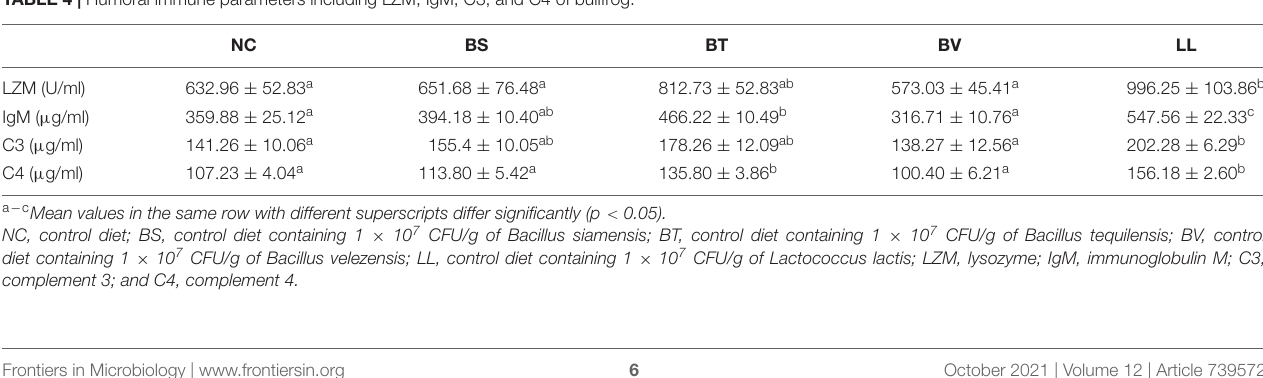
TABLE 4 | Humoral immune parameters including LZM, IgM, C3, and C4 of